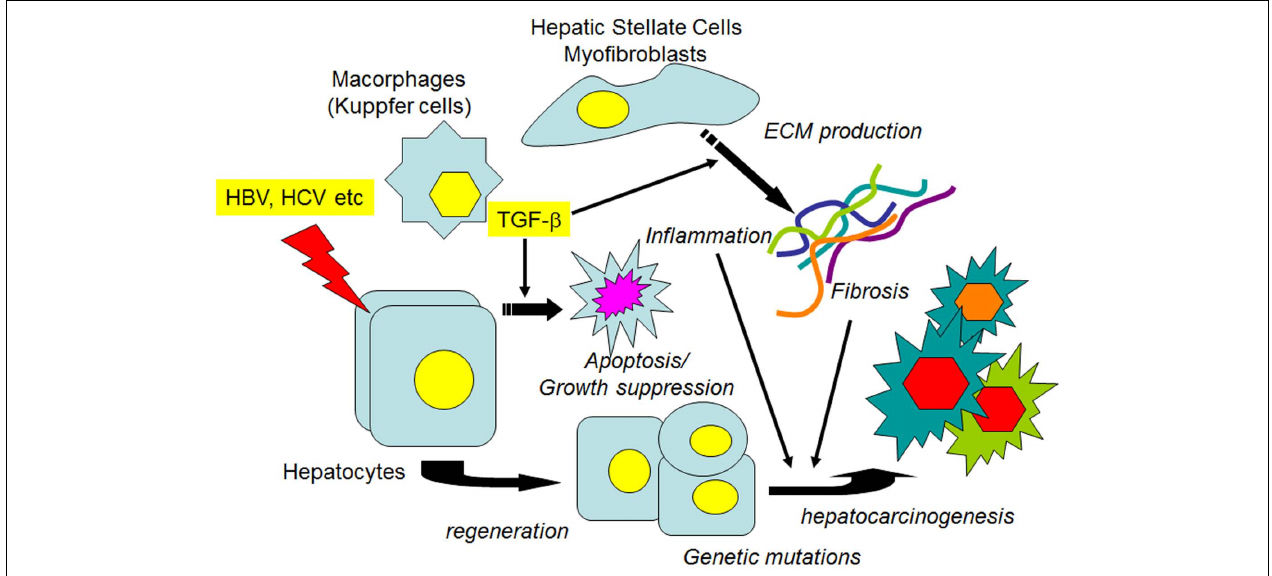
injurious stimuli are persistent, ECM protein production from the activated HSCs/myofibroblasts is continuously stimulated. Both persistent inflammation and the accumulated ECM proteins contribute to the alteration of signal transduction pathways in regenerated hepatocytes, along with the accumulation of genetic mutations, which leads to the preneoplastic changes of hepatocytes and the eventual development of HCC.